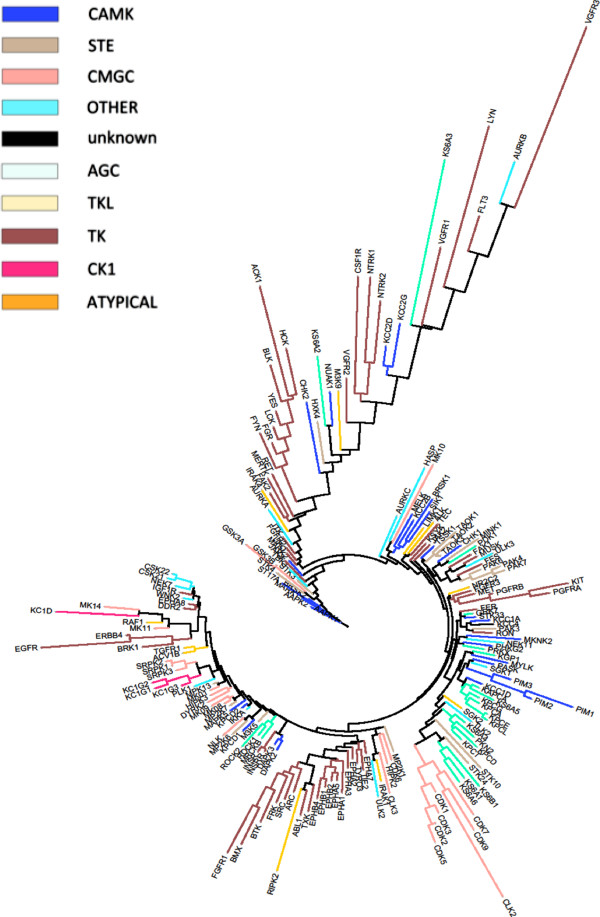
Kinome tree constructed with a distance matrix based on fingerprint enrichment profiles after exclusion of kinases with 16 or fewer shared activities. Kinases were colored based on the classification of kinase groups as defined by Manning et al[5]. The new tree shows good agreement with the tree constructed earlier. In particular, CDK and CLK kinases are grouped together (with only CDK6 being out of the cluster). Protein C kinases are slightly more spread over 2 small clusters, but as a whole still remain close in the new tree as well. Tyrosine kinases remain clustered together, in particular the Ephrin kinases.